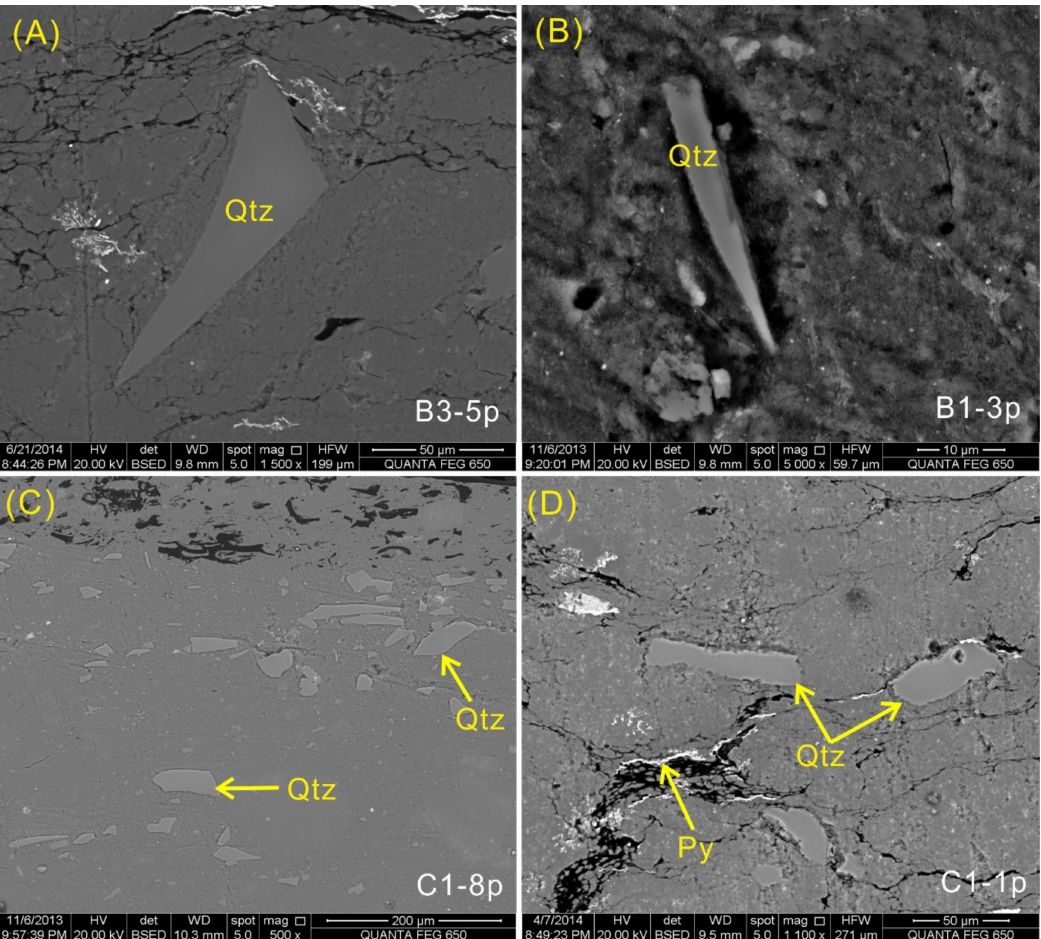
Figure 12. SEM back-scattered electron images of quartz in tonsteins. ( A – C ) Sharp-edged quartz in samples B3-5p, B1-3p, and C1-8p. ( D ) Corroded quartz and pyrite veinlets in C1-1t. Qtz: quartz. Py: